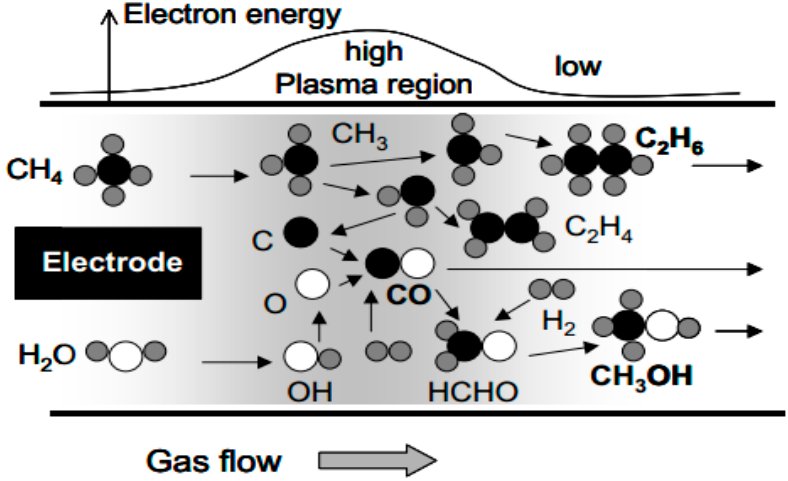
Figure 24. Major reaction pathways for the conversion of CH 4 to CH 3 OH in CH 4 /H 2 O plasma. The upper part shows a schematic of the electron energy variation along the gas flow. Reproduced with permission from [152]. Copyright 2013 Springer.